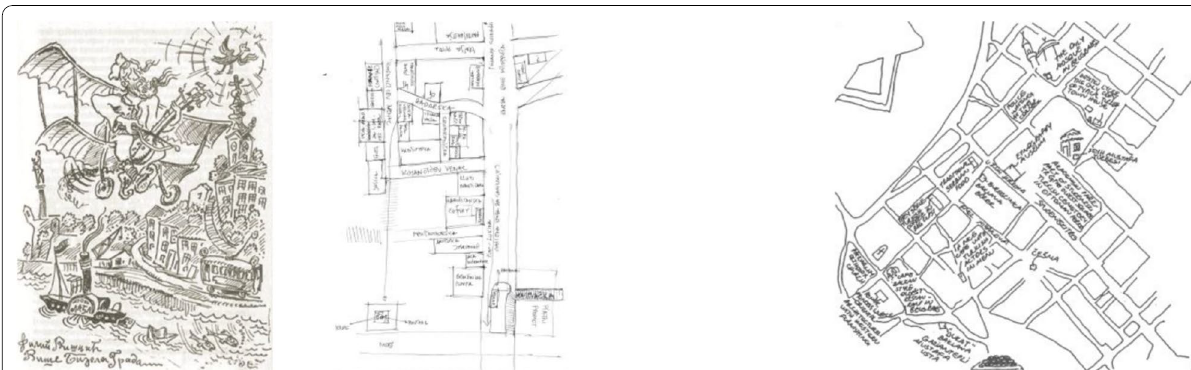
Fig. 9 Experience of ambiences in Kosančićev venac—inhabitant (left) and visitor